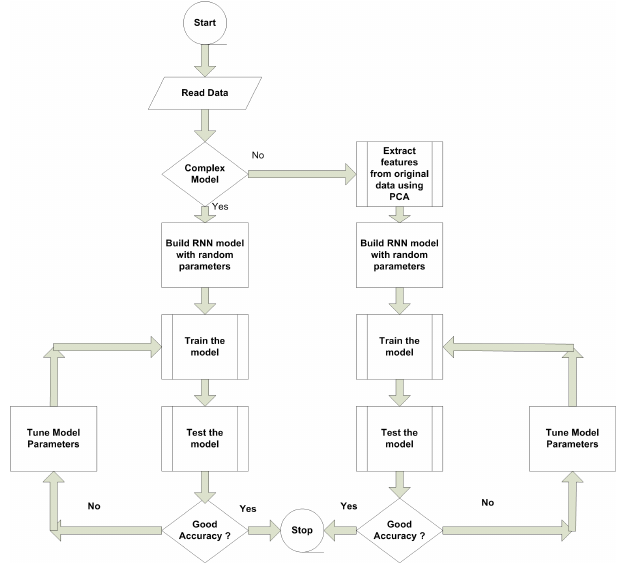
Figure 2. Proposed work flow diagram.